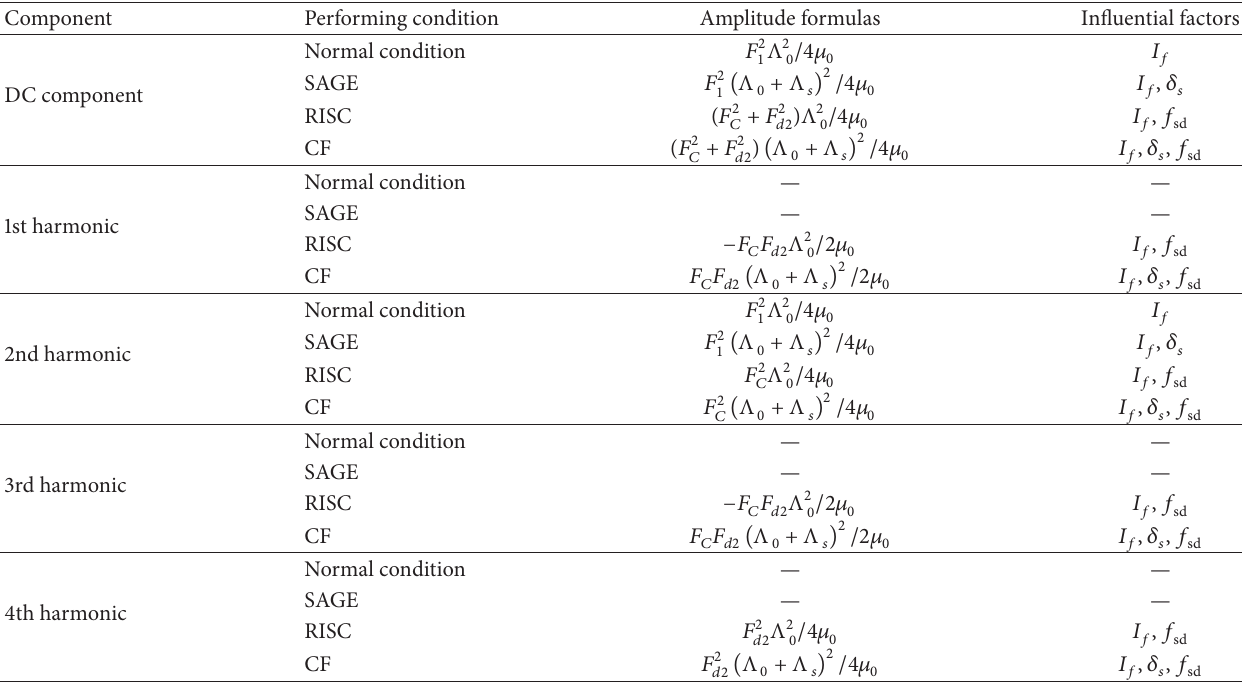
Table 1: Upper amplitude expressions of MPPUA for different conditions.